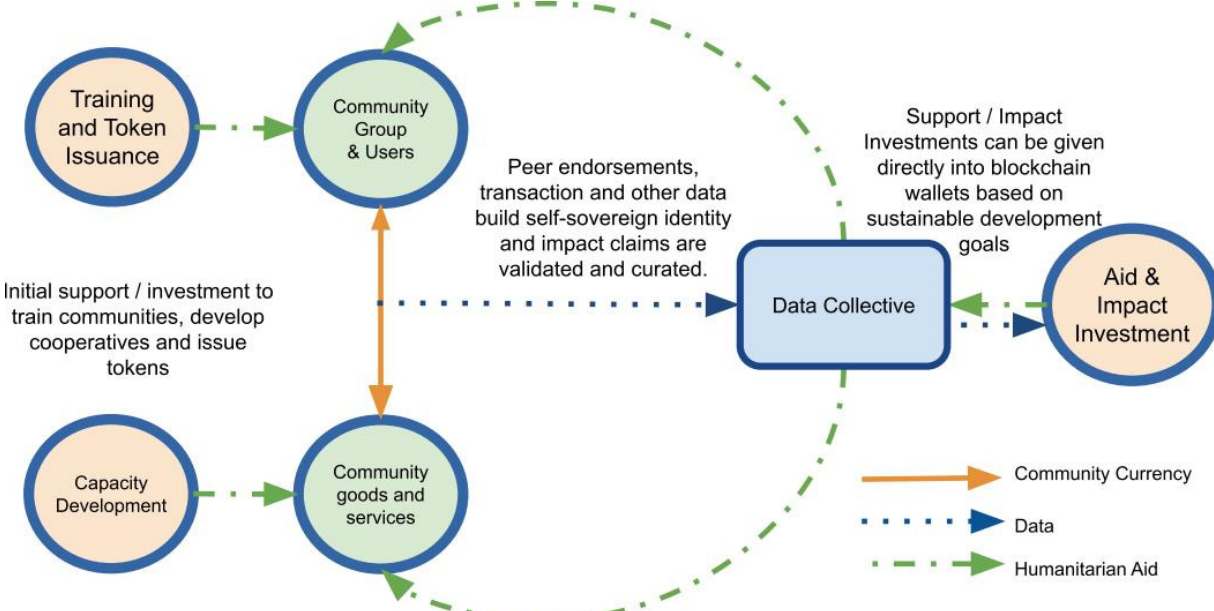
Figure 6. Grassroots Economics Complementary Currency (CC) Model on the xDai blockchain 2020–2021.